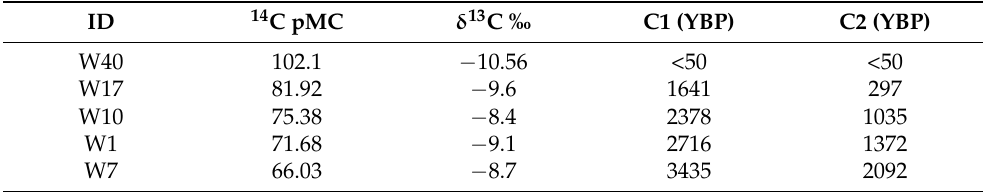
Table 2. The calculated 14 C -age of groundwater with initial 14 C activity of 100 pMC for C1 and 85 pMC for C2 (YBP: years before